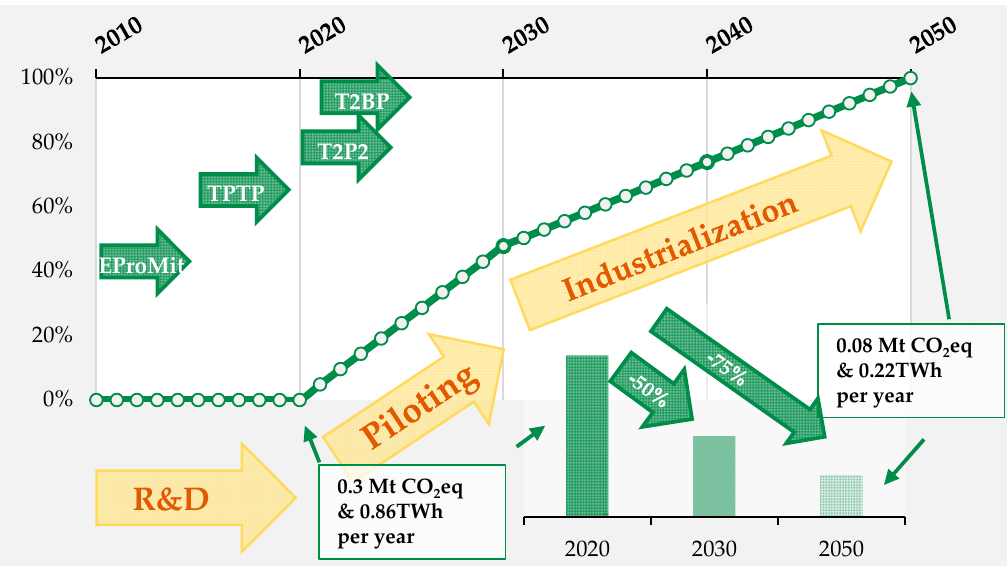
Figure 6. Roadmap for climate neutral biologics manufacturing by Bundesministerium für Wirtschaft und Energie (BMWi; English: Federal Ministry for Economic Affairs and Energy)-funded projects. Bundesministerium für Wirtschaft und Energie (BMWi; English: Federal Ministry for Economic Affairs and Energy), Energieeffiziente Prozesse durch Mikro-Trenntechnik (EProMit; English: Energy-Efficient Processes by Micro-Separation Technology), Traceless Plant Traceless Production (TPTP), Total Traceless Biologics Plant (TTBP), Total Traceless Phyto Plant (T2P2), research and development (R&D).